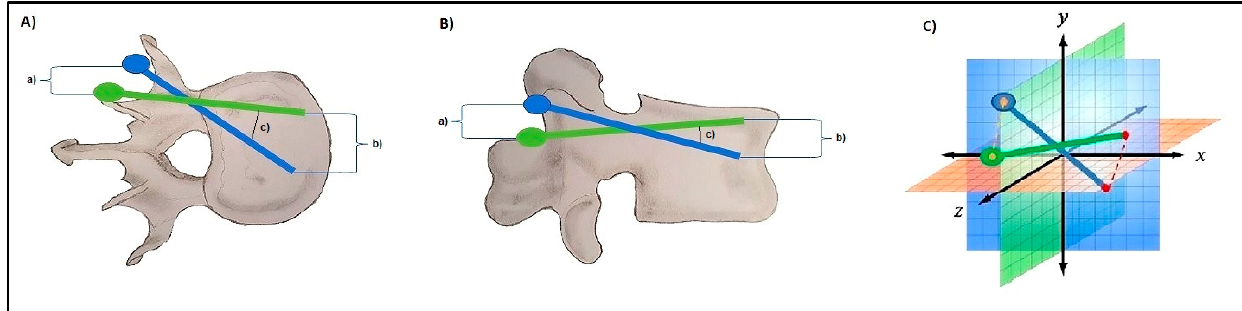
Figure 2. Graphic illustration of the methodology for measuring screw accuracy: Euclidian distances were calculated in 3D-space from point coordinates to yield mean absolute distances (MAD) be- tween screw heads (a), screw tips (b) and angular deviation (c) between planned screw trajectory (exemplified in green) and final screw position (exemplified in blue); Methodology illustrated for axial ( A ) and sagittal ( B ) planes and in 3D-space ( C ).